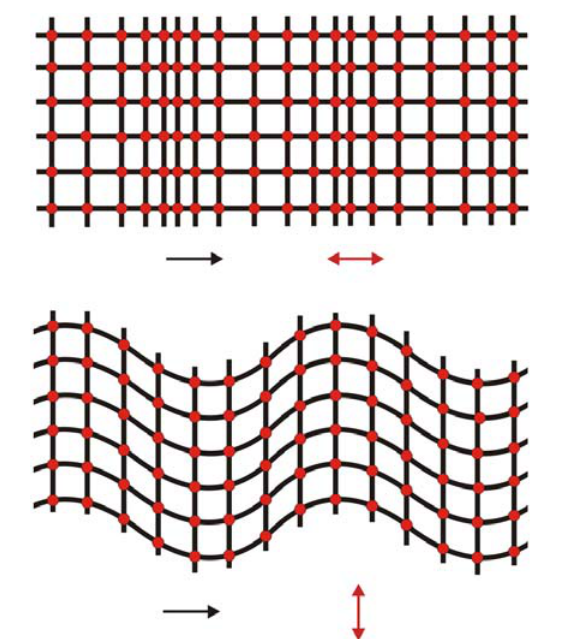
Figure 10. Top view of particle displacements of plane acoustic waves propagating in a solid. (Top) longitudinal or compressional wave. (Bottom) shear or transverse wave. Black arrows indicate the wave propagation direction and red arrows indicate the particle displacement